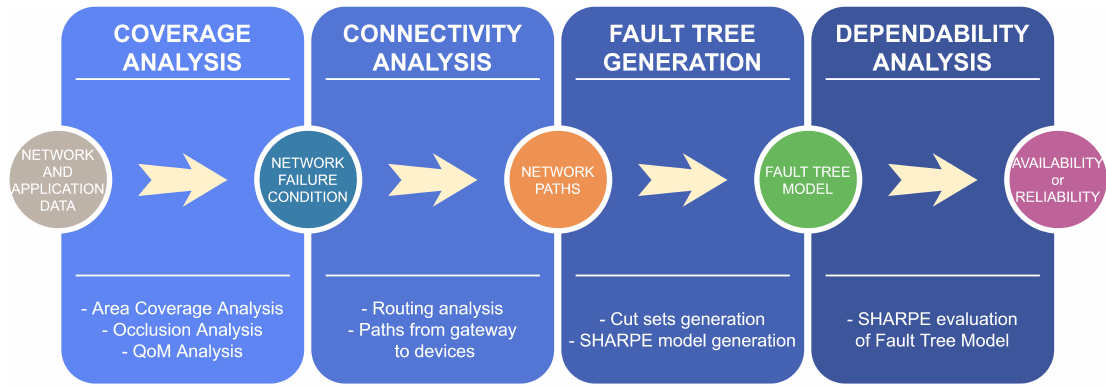
Figure 5. Flowchart of the proposed evaluation methodology.